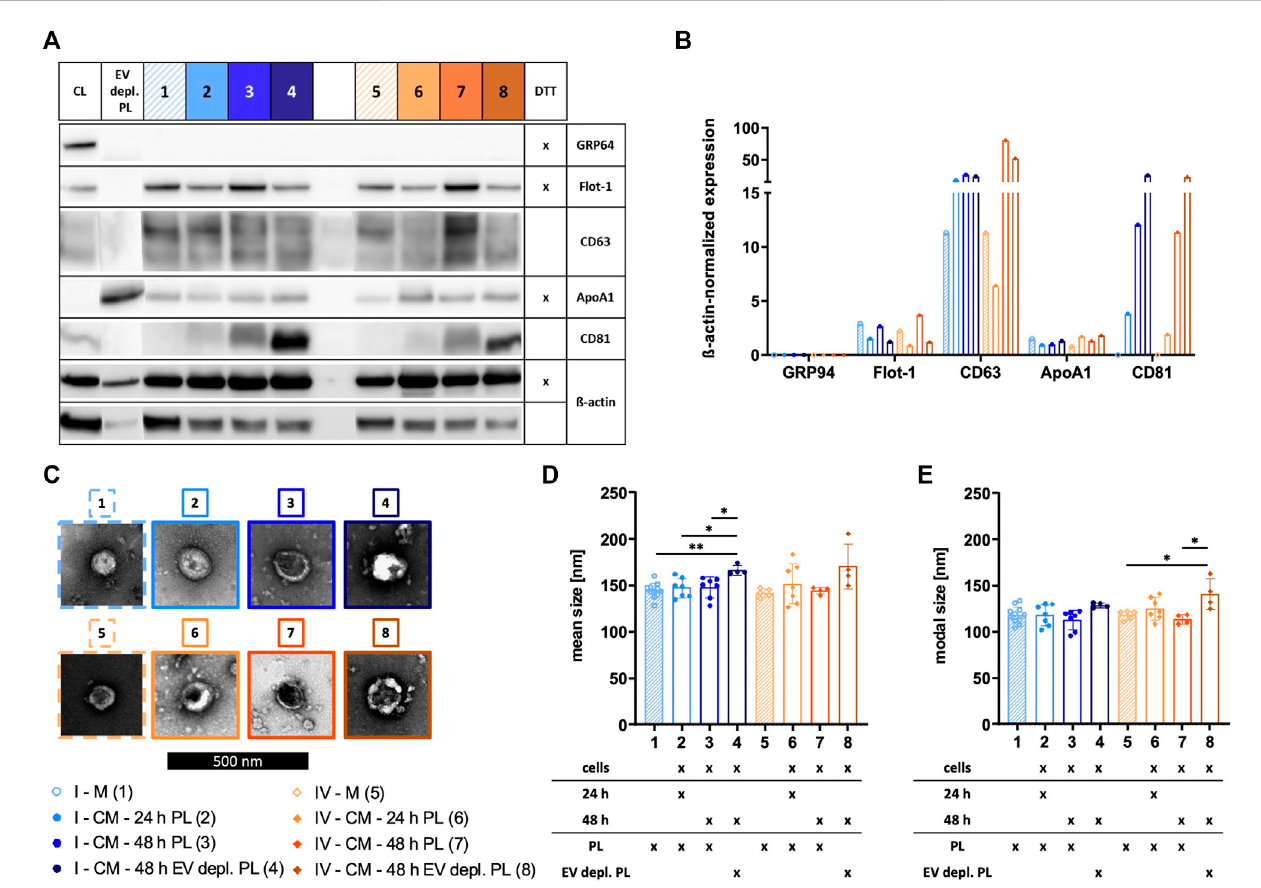
FIGURE 7 CharacterizationofsEVscollectedwithdifferentstrategies.sEVswereisolatedfrom α MEM+8%PL(M)(1and5;withstripes)inordertoverifythepresence of PL-derived sEVs in the media. MSCs were grown in α MEM+8% PL and α MEM+8% EV depl. PL. sEVs were collected for 24 h (2 and 6) and 48 h (3 and 7) for α MEM+8% PL cultures and for 48 h for α MEM+8% EV depl. PL cultures (4 and 8). Methods I (blue scheme) and IV (orange scheme) were used for sEV isolation from M and CM. (A) Western blotting was performed in order to investigate the expression of proteins GRP94, Flot-1, CD63, ApoA1, and CD81. MSC cell lysate(CL)andEVdepl.PLservedascontrolsforprimaryantibodies,andß-actinwasusedasloadingcontrol.Reducingconditionsforindicatedproteinswere obtained by the addition of dithiothreitol (DTT). (B) Chemiluminescent signal intensities were quanti fi ed and normalized on ß-actin intensities, resulting in ß- actin-normalized expression of proteins. (C) sEVs were visualized by negative contrast staining using TEM with 60,000 times magni fi cation. The black scale barrepresents500 nm. (D) + (E) MeanandmodalsizeofsEVswasdeterminedbyNTA.RepresentativeimagesaredepictedforwesternblottingandTEM.Data arepresentedasmean±SD,andN ≥ 4independentexperimentswereperformedforNTAanalyses.Statisticallysigni fi cantdifferencesaredepictedasfollows: *: p < 0.05, **: p <